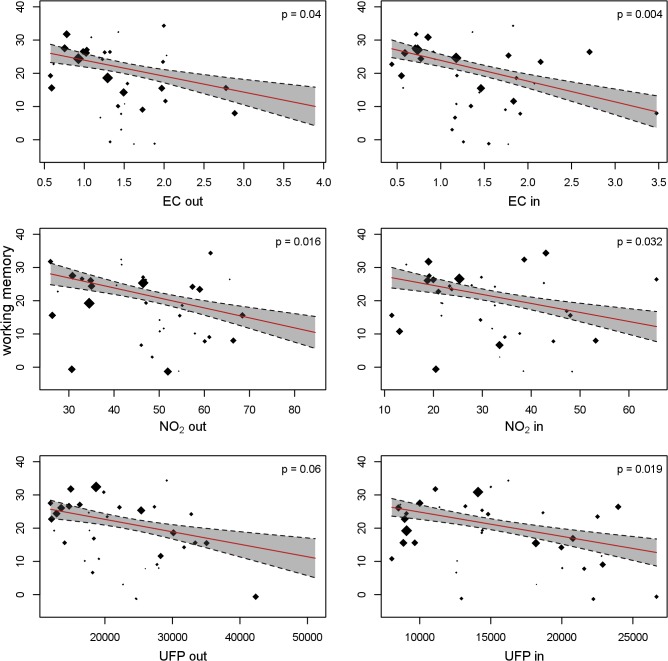
Working memory development and long-term exposure to traffic-related air pollutants.Each dot depicts a school, with size proportional to the number of children. The cognitive development per school was estimated in a model with school and individual as random effects. The slope of the red line depicts the change in cognitive development as a function of the air pollutants, adjusted for age, sex, maternal education, residential neighborhood socioeconomic status, and air pollution exposure at home; school and individual as nested random effects in 2,715 children and 10,112 tests from 39 schools. Gray shading indicates 95% CIs. out, outdoors (courtyard); in, indoors (classroom).